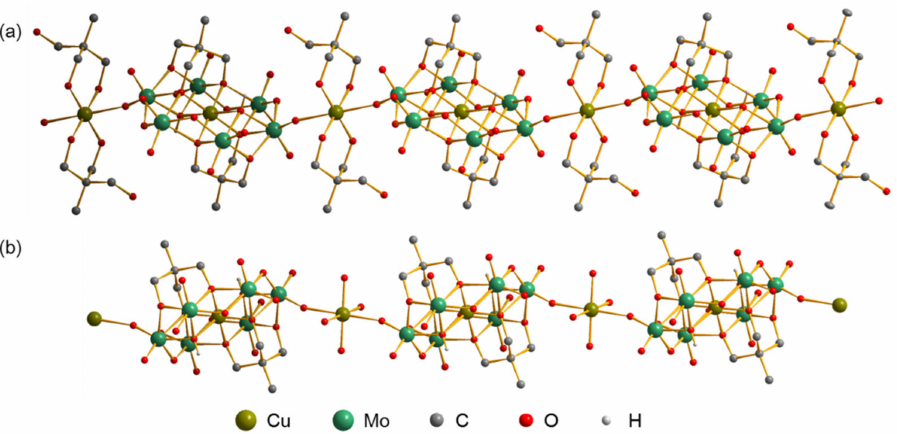
Figure 2. Ball-and-stick representations of compounds ( a ) 6 and ( b ) 7 , showing their 1D chain structures. All H atoms except those attaching to tri-bridging O atoms in polyanions are omitted for